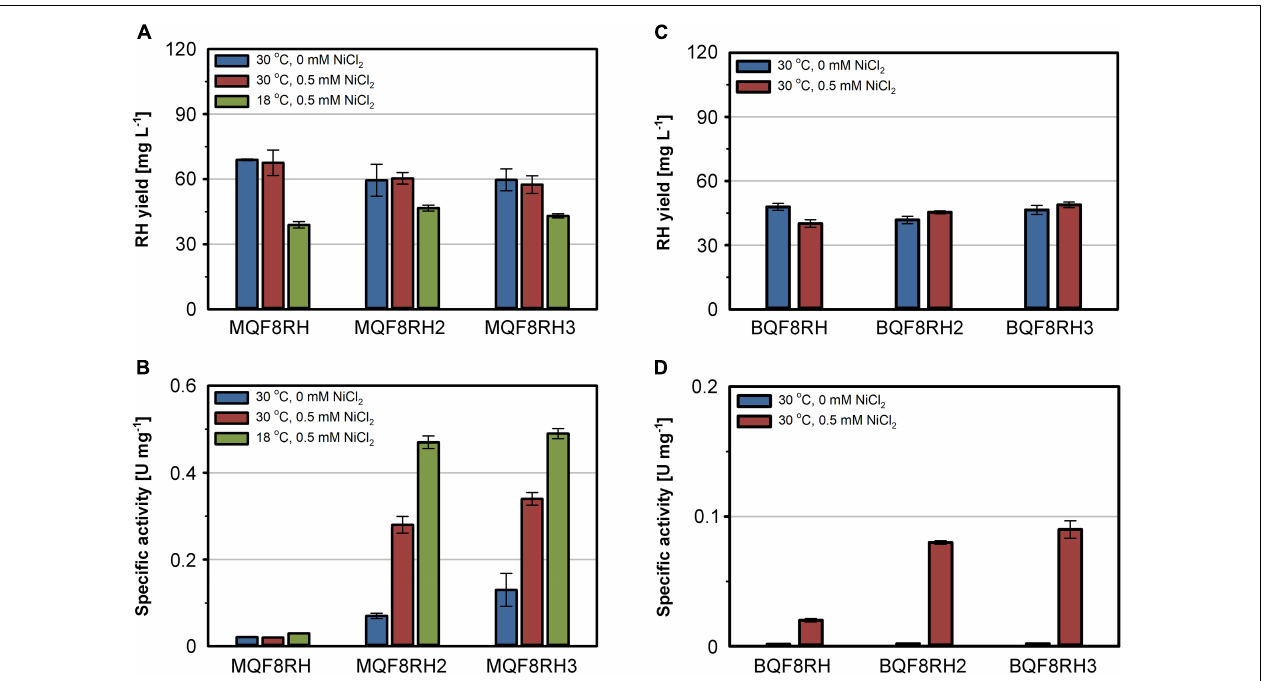
FIGURE 2 | Effect of NiCl 2 addition and cultivation temperature on RH yield and activity. Strains E. coli MQF8RH, MQF8RH2, MQF8RH3, BQF8RH, BQF8RH2 and BQF8RH3 were cultivated in 125 mL PreSens flask with 50 mL boosted EnPresso B medium under O 2 -limited conditions. After induction, the temperature was